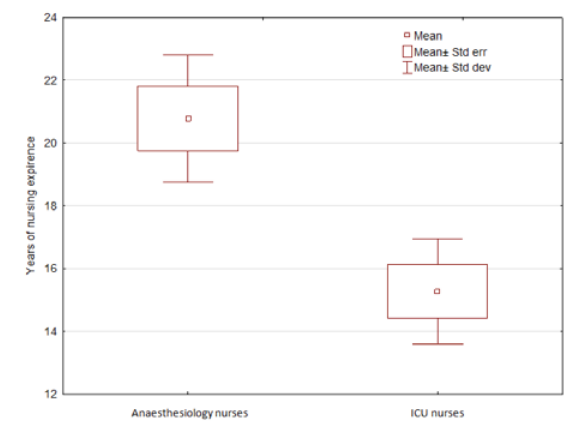
Figure 2: Professional experience of nurses in anaesthesiology and intensive care wards. Frame table –